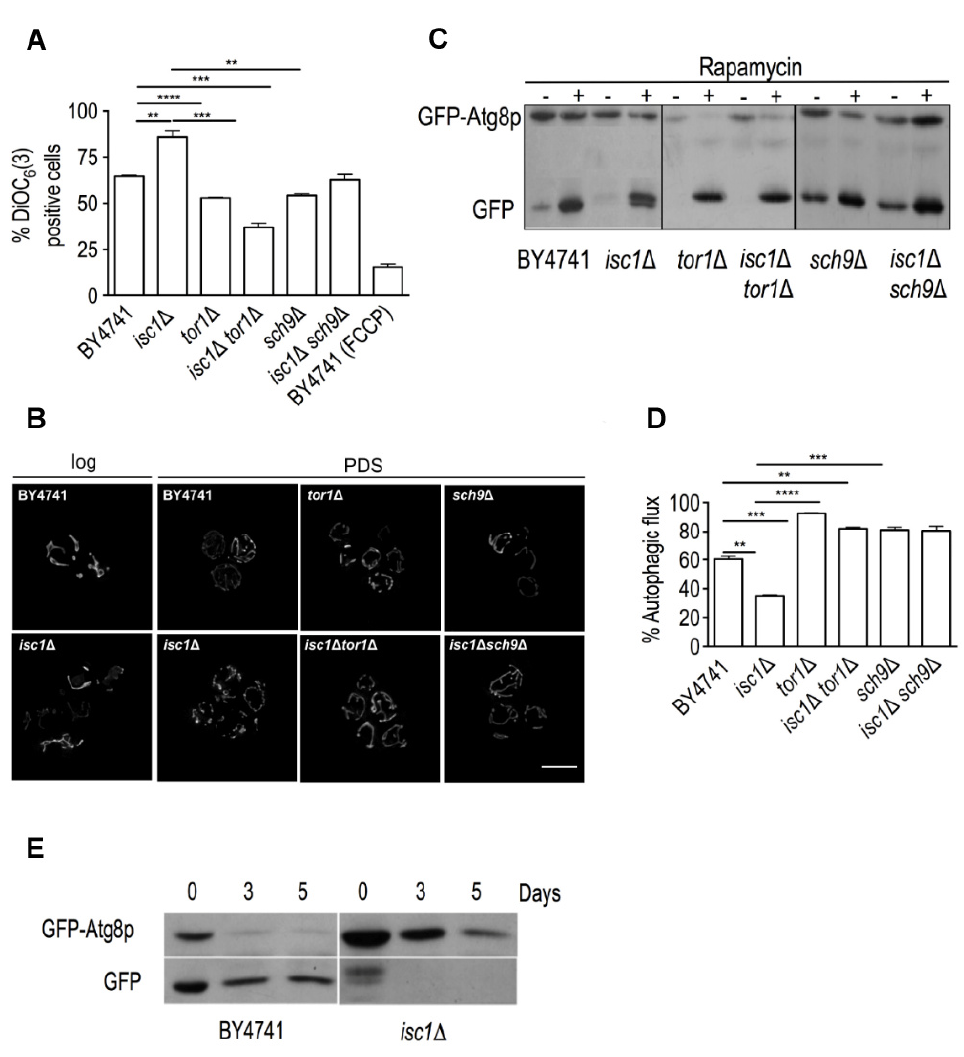
FIGURE 4: The mitochondrial membrane hyperpolarization and decreased autophagic flux contribute to mitochondrial dysfunction and impairment of mitochondrial dynamics in isc1 Δ cells. (A) S. cerevisiae BY4741, isc1 Δ, tor1 Δ and isc1 Δ tor1 Δ, sch9 Δ and isc1 Δ sch9 Δ cells were grown in SC-medium to the PDS phase, stained with the potential-sensitive dye 3,3-dihexyloxacarbocyanine iodide [DiOC 6 (3)] for 30 min and analyzed by flow cytometry. Treatment of the parental strain (BY4741) with FCCP (carbonyl cyanide 4-(trifluoromethoxy)phenylhydrazone) was used as a positive control (depolarizing event). Values are mean ± SD of at least three independent experiments. ****p<0.0001; ***p<0.001; **p<0.01. (B) Yeast cells transformed with pYX222-mtDsRed were grown to the exponential and PDS phases and analyzed by fluorescence microscopy, as described in Materials and Methods . Live cells were visualized by fluorescence microscopy. A representative ex- periment out of three is shown. Scale bar: 5 µm. (C) S. cerevisiae BY4741, isc1 Δ, tor1 Δ and isc1 Δ tor1 Δ, sch9 Δ and isc1 Δ sch9 Δ cells carrying pRS416 GFP- ATG8 were grown to the exponential phase in SC-medium and treated with either rapamycin (200 ng/mL) or DMSO (vehicle) for 3 hours. Proteins were analyzed by immunoblotting, using anti-GFP antibody. (D) The autophagic flux was calculated by the ratio between the free GFP signal and the sum of free GFP and GFP-Atg8p signals. Values are mean ± SD of at least three independent experiments ****p<0.0001; ***p<0.001; **p<0.01. (E) S. cerevisiae BY4741 and isc1 Δ cells carrying pRS416 GFP- ATG8 were grown to PDS phase, washed twice with water and then maintained in water. Proteins were analyzed by immunoblotting, using anti-GFP